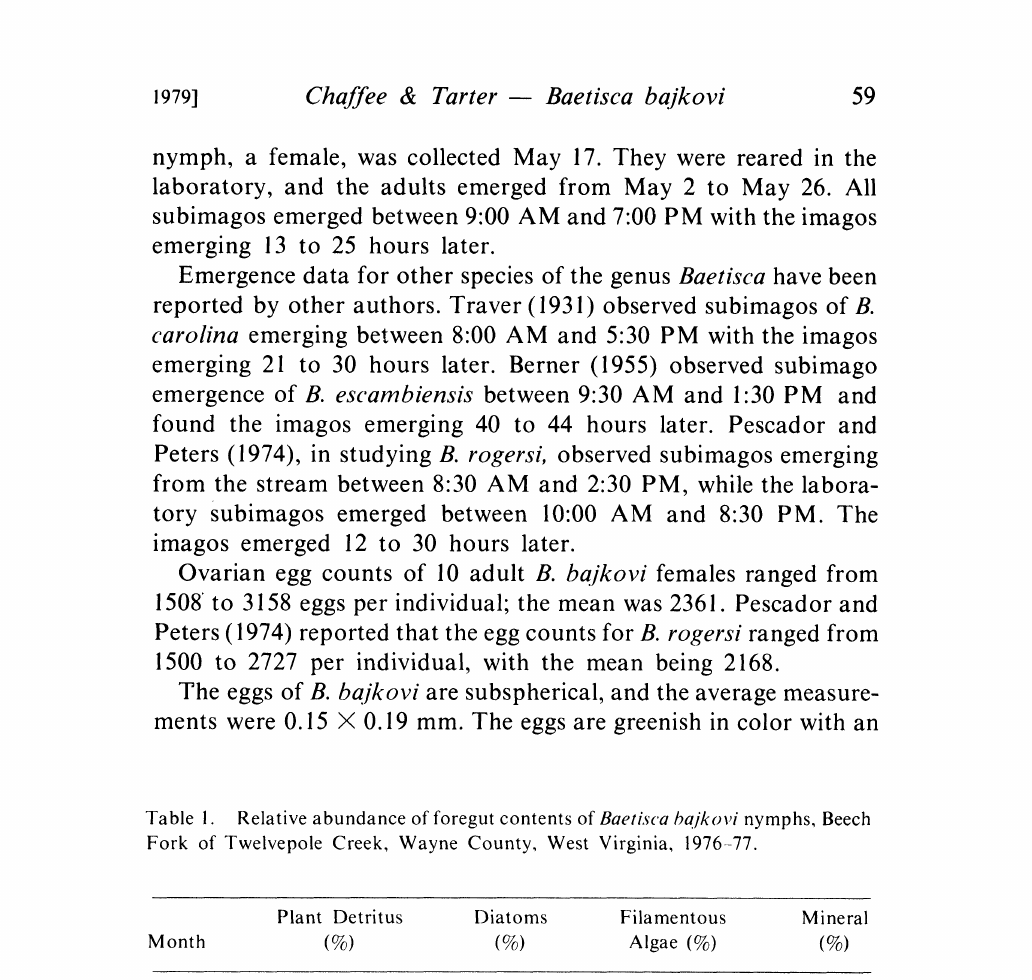
Table 1. Relative abundance of foregut contents of Baetisca ba/kovi nymphs, Beech Fork of Twelvepole Creek, Wayne County, West Virginia, 1976-77. Plant Detritus Diatoms Filamentous Mineral (%) (%) Algae (%) (%) Month July